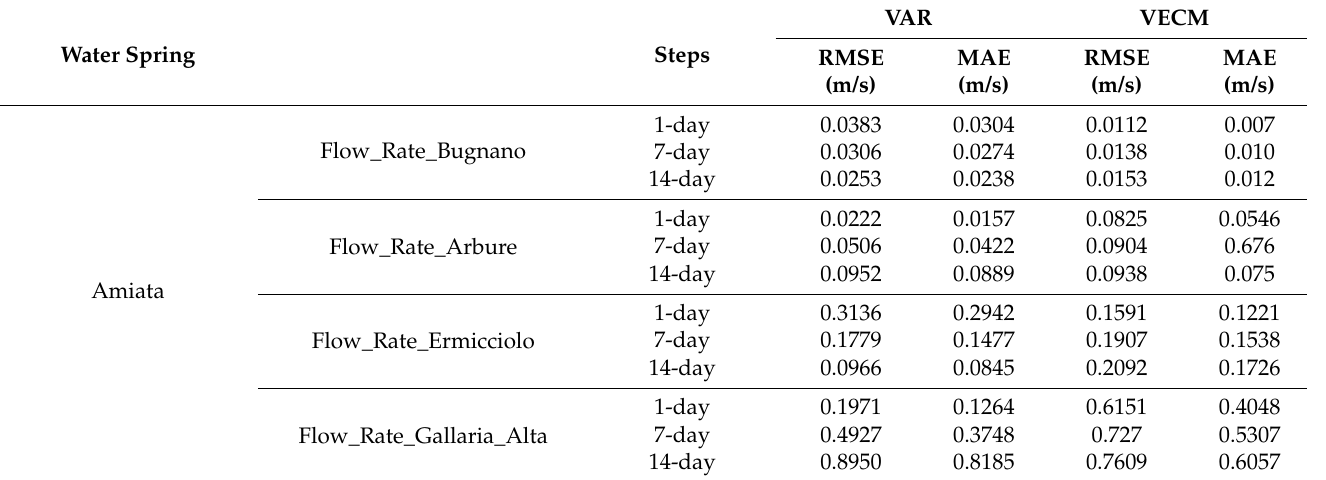
Table 4. Summary of Flow rate (water